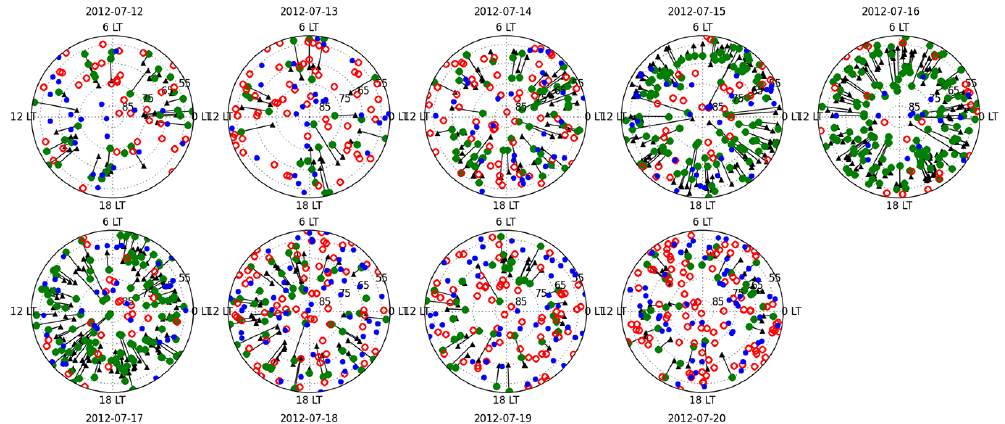
Figure 5. Locations of COSMIC electron density profiles for the July 2012 storm period in MLT/geomagnetic latitude coordinates for the Northern Hemisphere. Green circles indicate the presence of a E region density layer, open red circles indicate no layer present, and blue circles are ambiguous. The climatological boundary from IRI2012 is indicated as in Fig. 4.